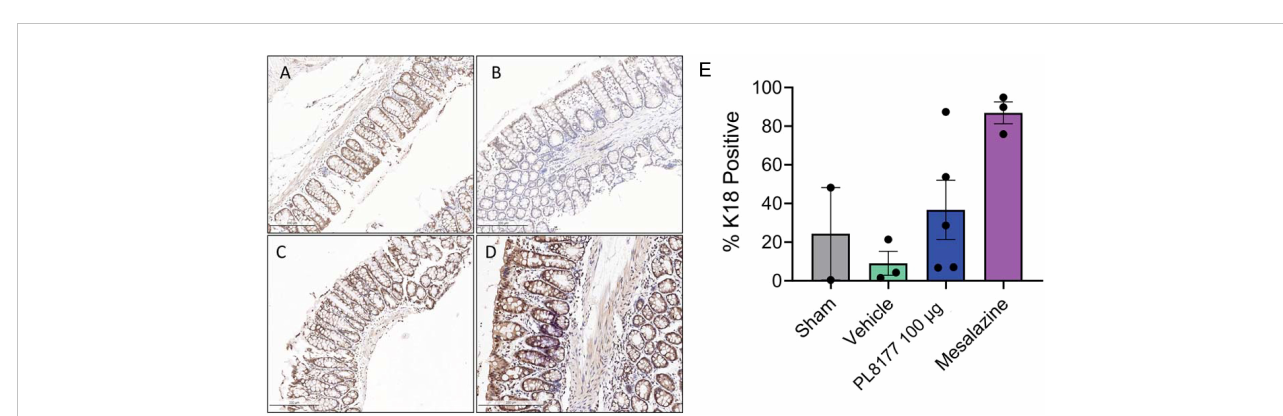
FIGURE 6 Representative colon immunohistochemistry for K18 sections of DSS colitis-induced rats. Sham (A) is no challenge and no treatment. Placebo/vehicle control (B) is no treatment but DSS challenge. (C) is DSS challenge and treatment with PL8177 (100 µg). (D) is DSS challenge and treatment with